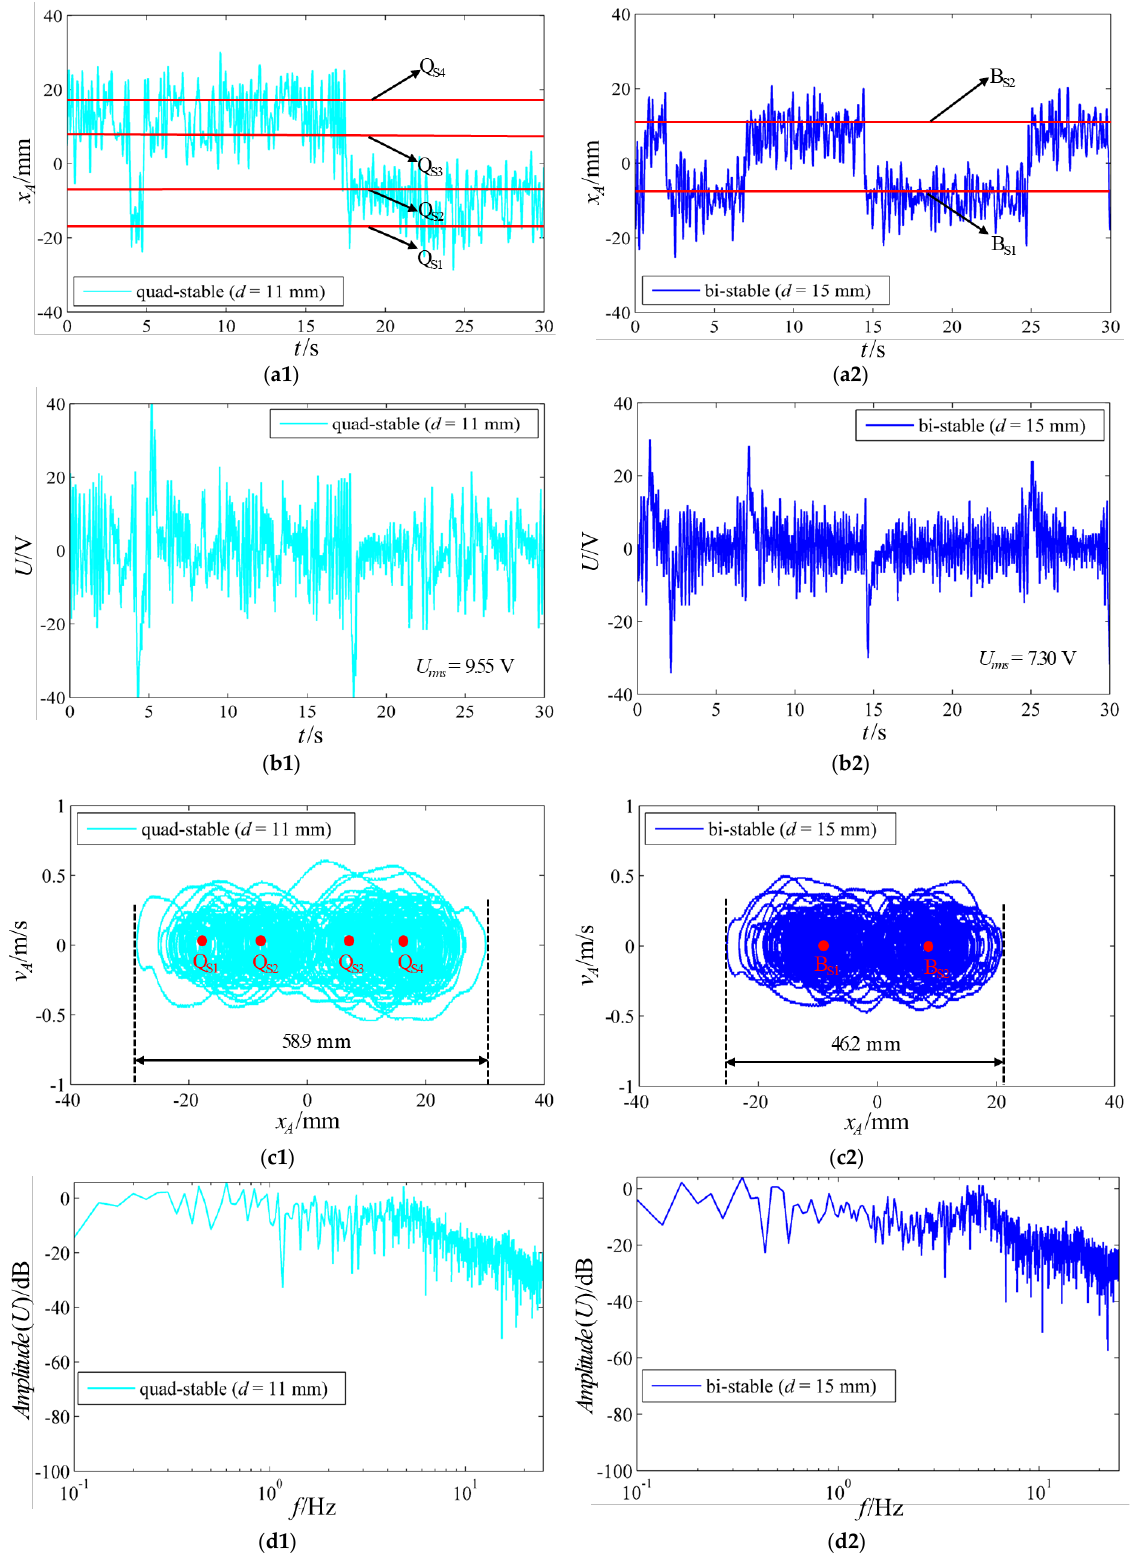
Figure 10. The experimental ( a1 ) output displacement, ( b1 ) open circuit voltage, ( c1 ) phase portrait, and ( d1 ) PSD of the voltage under the quad-stable structural parameters when a Arms = 1.57 g; the ( a2 ) output displacement, ( b2 ) open circuit voltage, ( c2 ) phase portrait, and ( d2 ) PSD of the voltage un- der the bi-stable structural parameters when a Arms = 1.64 g.